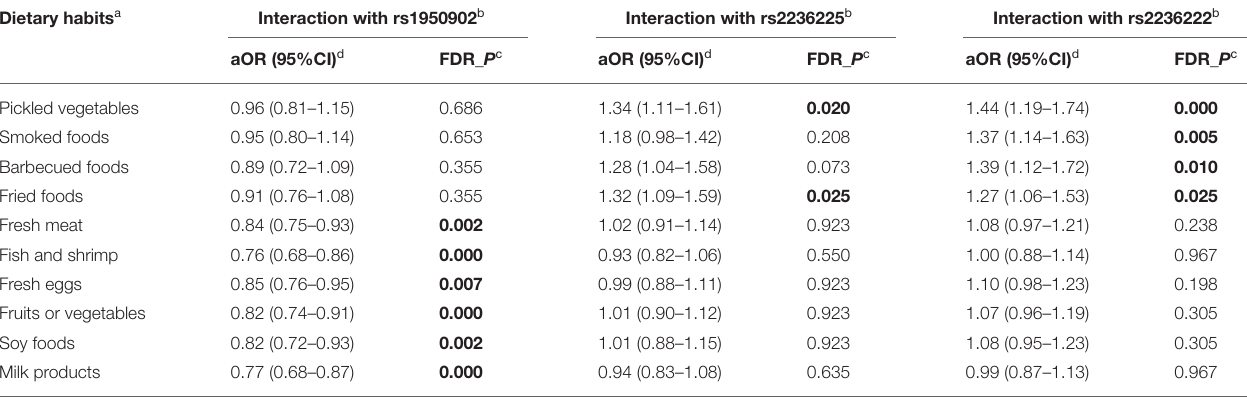
TABLE 5 | Interactions of maternal polymorphisms of MTHFD1 gene and maternal dietary habits by multivariate logistic regression. Dietary habits